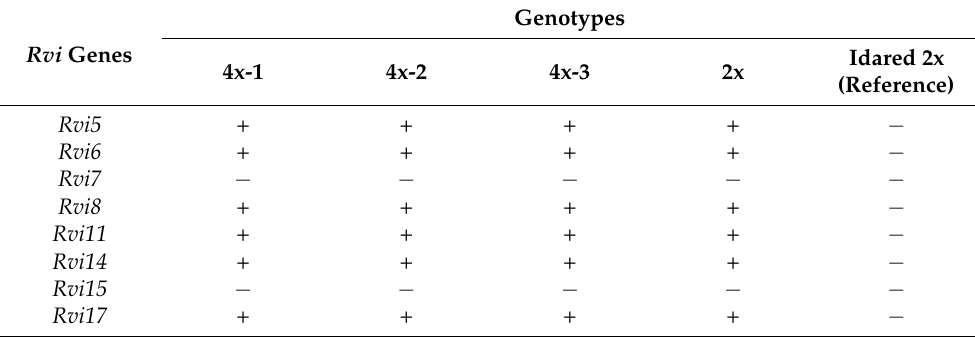
Table 3. Analysis of the presence of Rvi genes in tetraploid genotypes (4x-1, 4x-2, 4x-3) of ‘Free Redstar’ apple compared to the diploid (2x) counterpart and ‘Idared’ reference sensitive to apple scab. Genotypes Rvi Genes Idared 2x 4x-1 4x-2 4x-3 2x